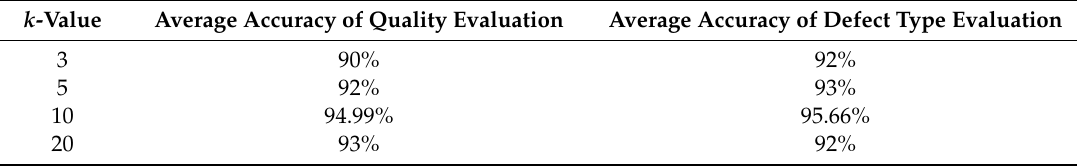
Table 4. Percentage of accuracy for di ff erent k -values in the algorithm.